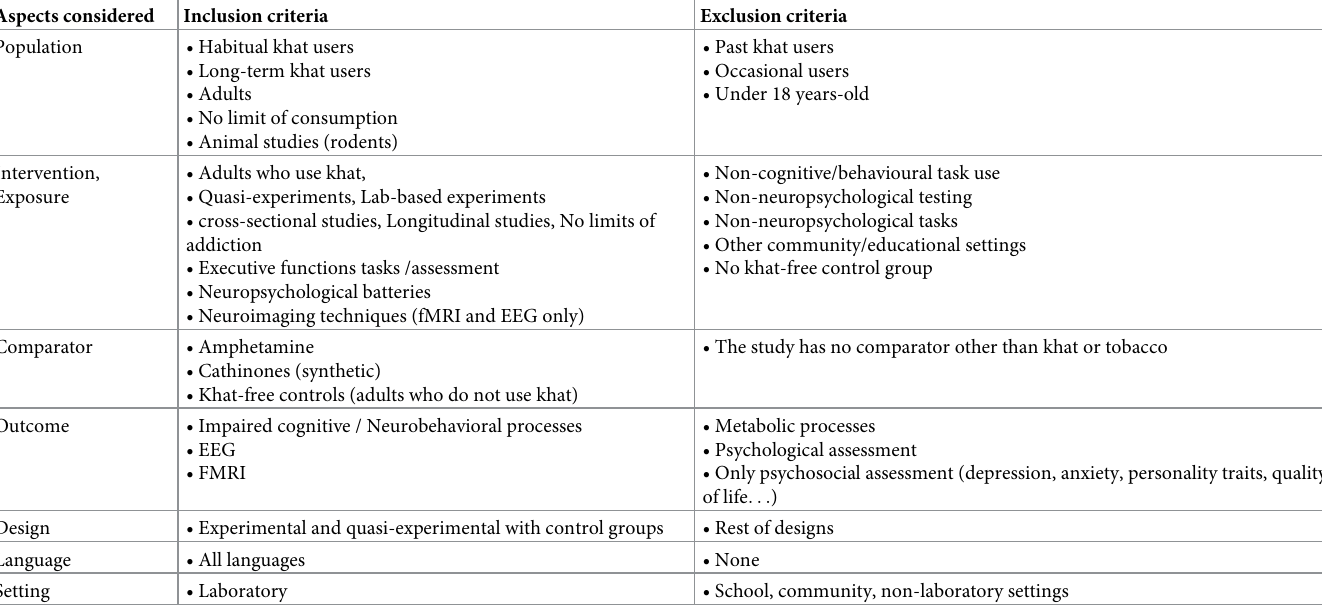
Table 1. Inclusion and exclusion criteria for the studies included in the